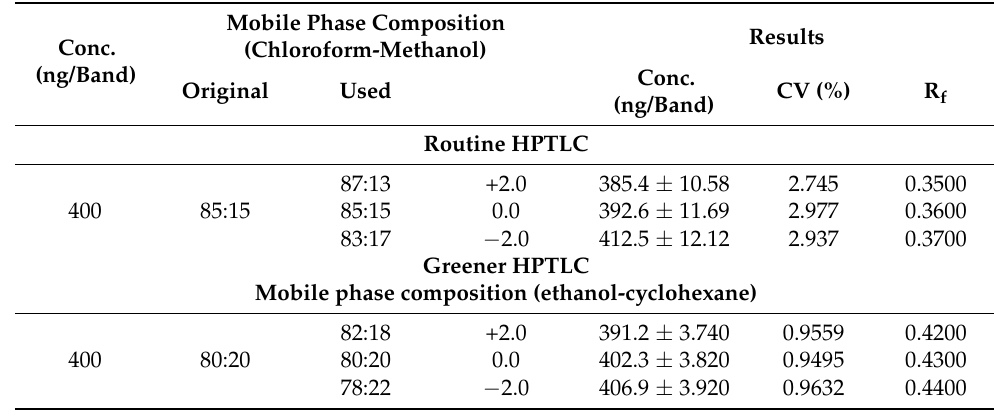
Table 5. Results of robustness analysis of GFT for the routine HPTLC and the greener HPTLC methods (mean ± SD; n =